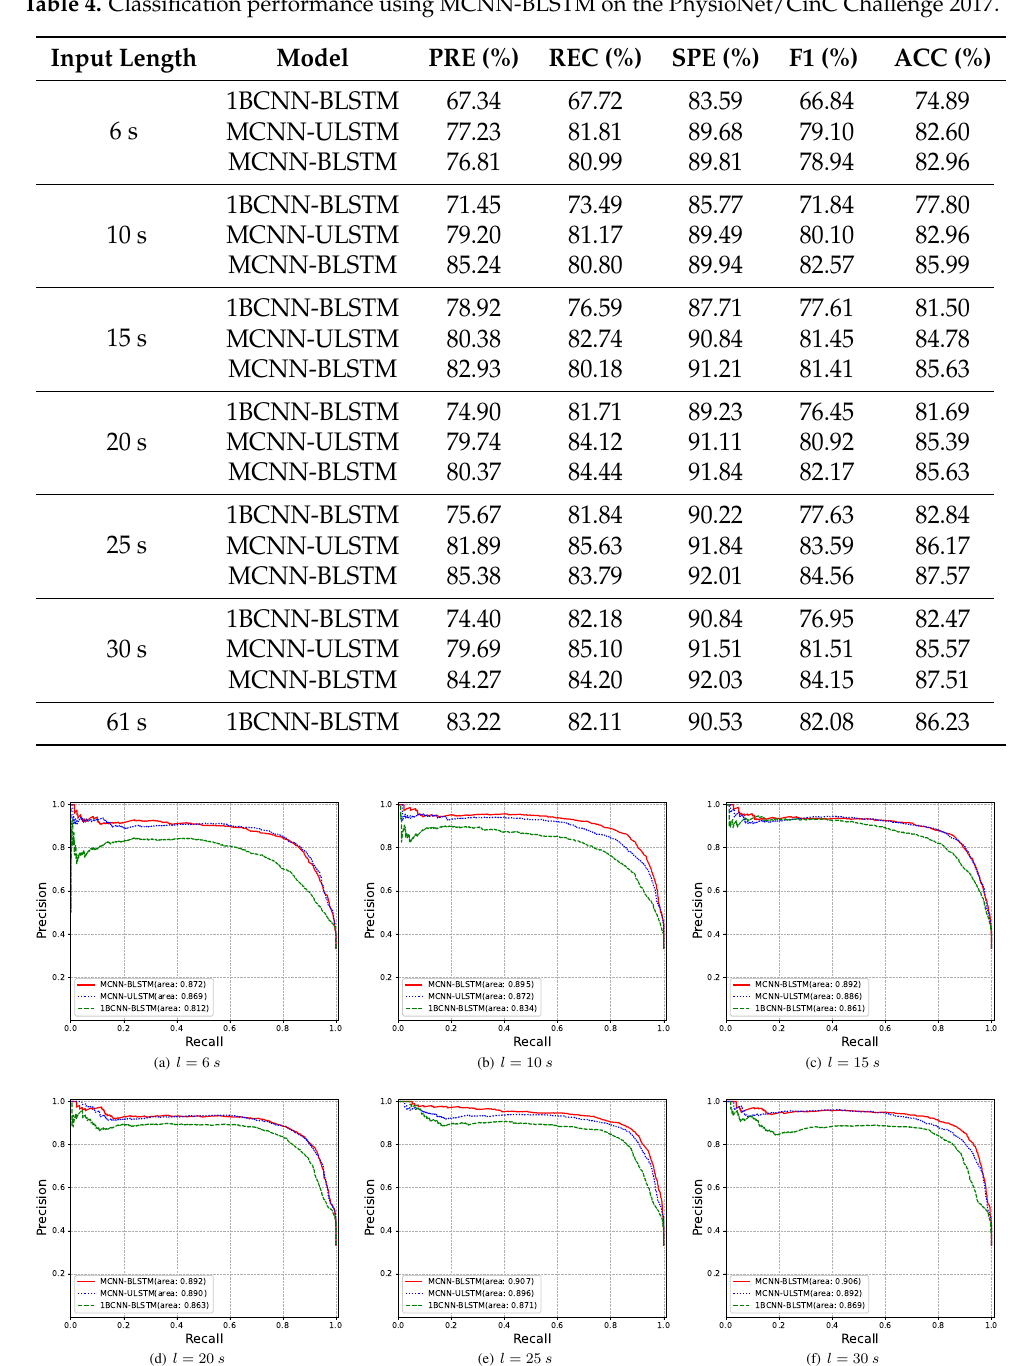
Figure 2. PR curves of the three models under the six input